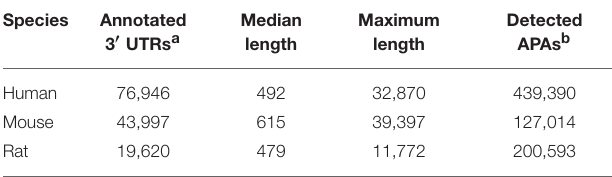
TABLE 1 | Summary statistics of annotated 3 ′ UTRs in the human, mouse, and